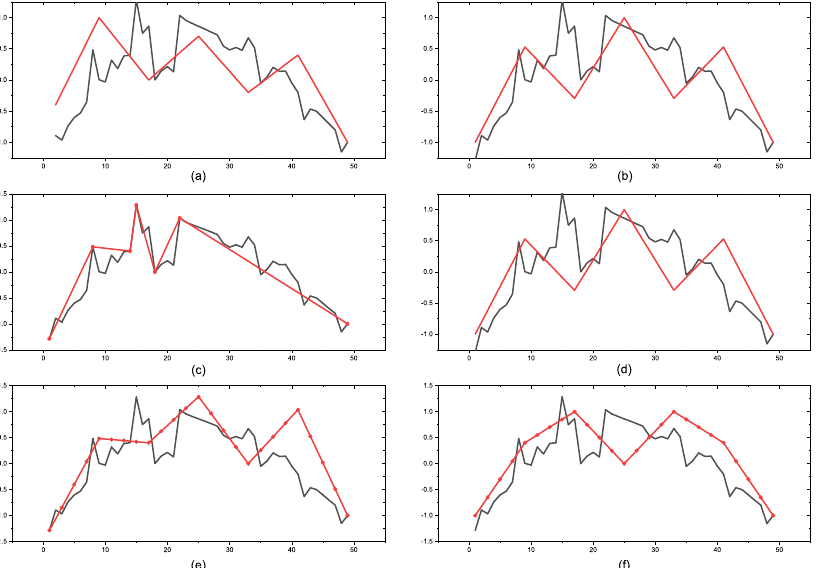
Figure 13. ( a ) The DTW algorithm mistakes the Doub-T testing sample (Black) as a Wedge pattern (Red). ( b ) The ED approach mistakes the Doub-T testing sample (Black) as a H&S pattern (Red). ( c ) The representation of PIP, ( d ) is the matching result of PIP, it mistakes the Doub-T testing sample (Black) as a H&S pattern (Red). ( e , f ) are the representation of scaling PIP and its matching result by LAHN, scaling PIP successfully recognizes the Doub-T pattern.